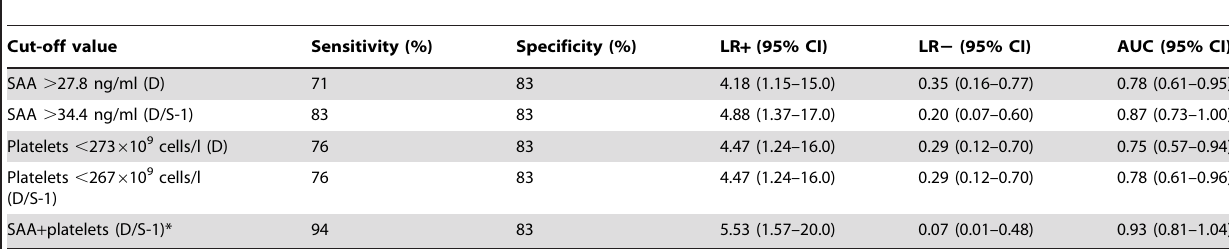
*Cut-off line described by the linear function: [platelet count (10 9 cells/l)] –25 N [SAA (ng/ml)] , 159.3. D=at diagnosis. D/S-1=at diagnosis (D) of neonates with moderate NEC, who were operated on the same day or who died; pooled with levels at one day prior to surgery (S-1) in neonates who were operated after the day of